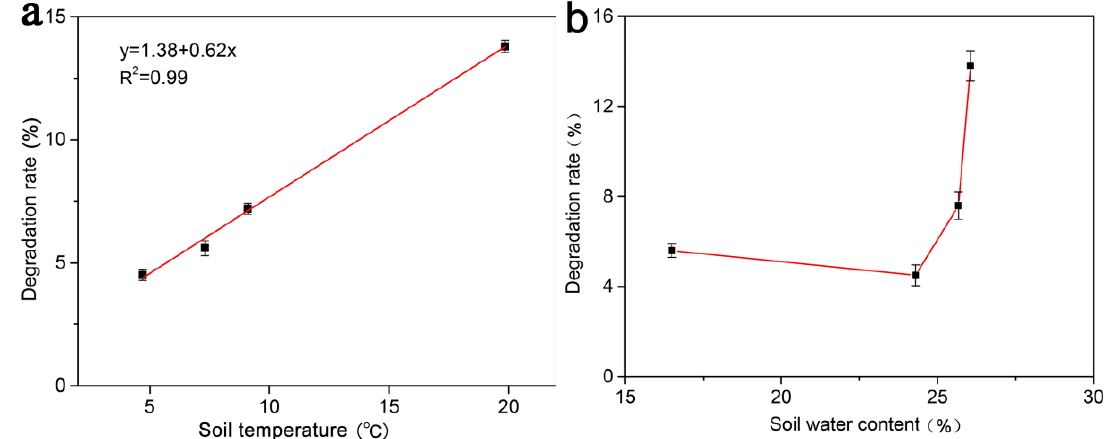
Figure 8. Effects of soil temperatures and soil water contents on the degradation of the MOF over a month. ( a ). Effects of soil temperatures on the degradation of MOF. ( b ). Effects of soil water contents on the degradation of content.